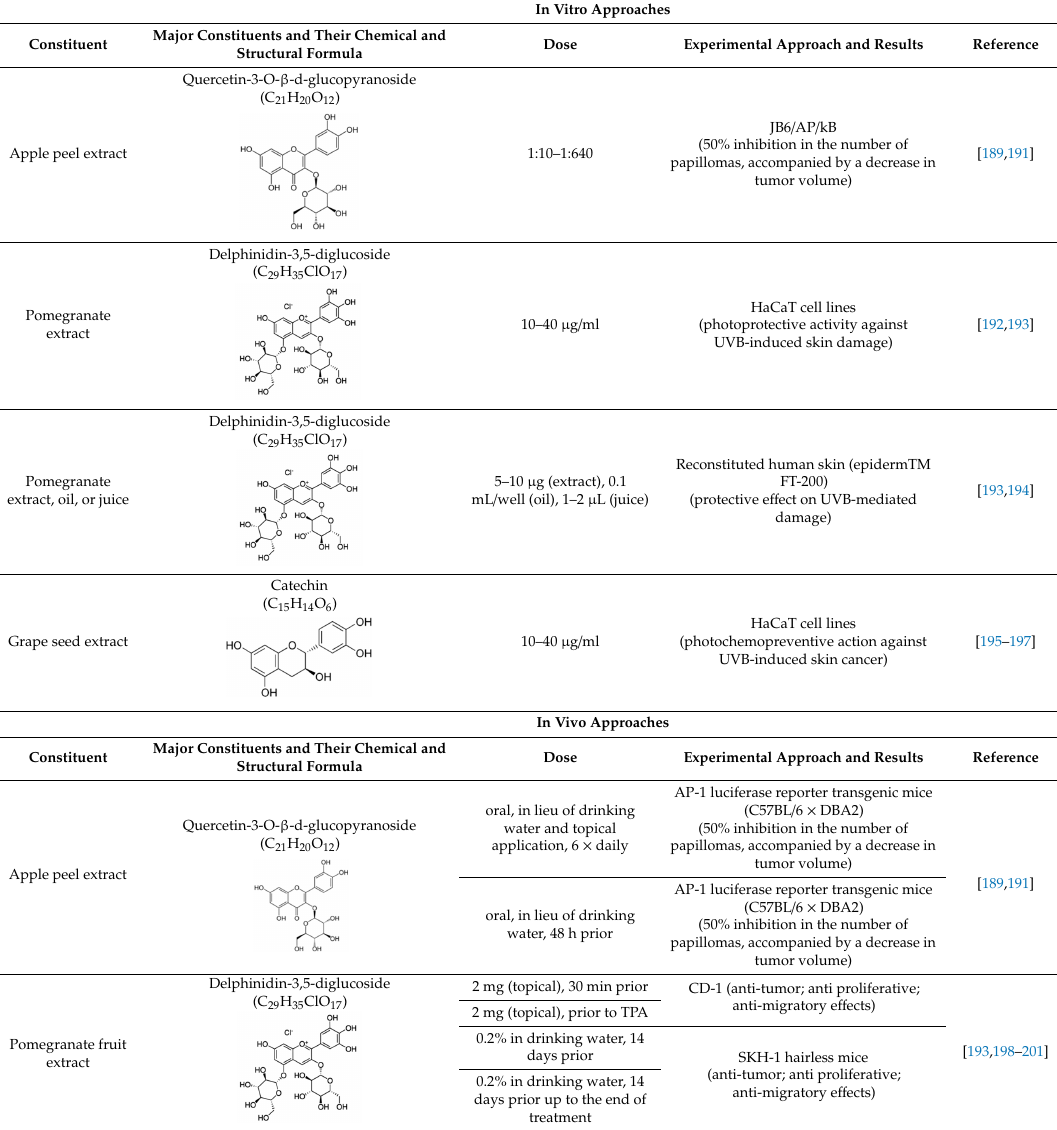
Table 2. Experimental approaches to analyze the effects of fruits and vegetables on skin cancer.